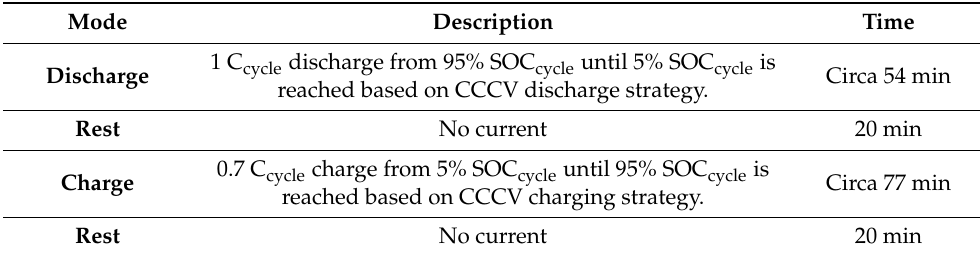
Table 1. Definition of the DC part of the cycle, where C cycle is the de-rated ampere–hour rating of the cell (updated after each characterisation test) and SOC cycle is the state of charge defined using C cycle .